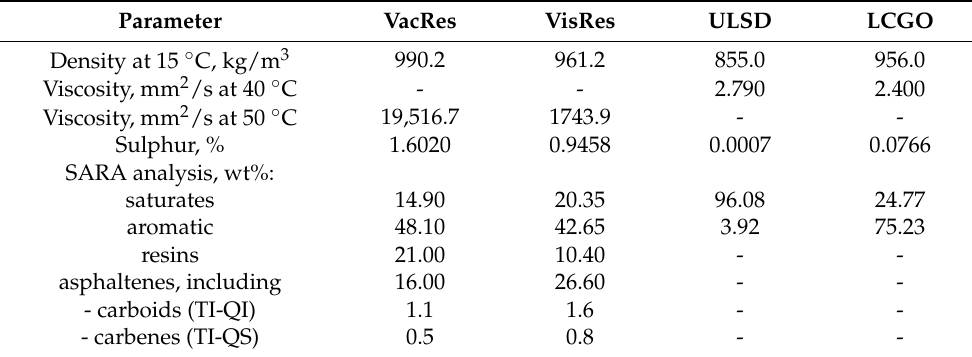
Table 1. Physical and chemical characteristics of marine fuel